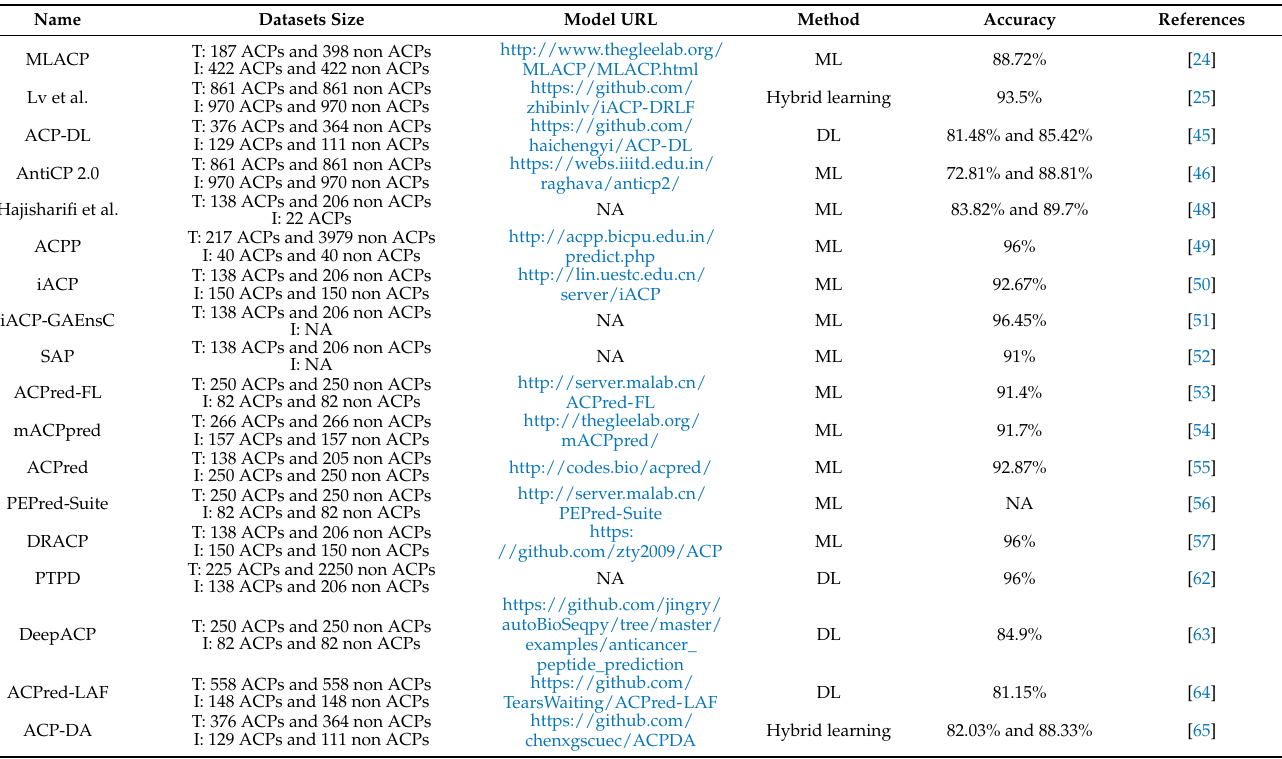
Table 2. List of AI tools for ACP